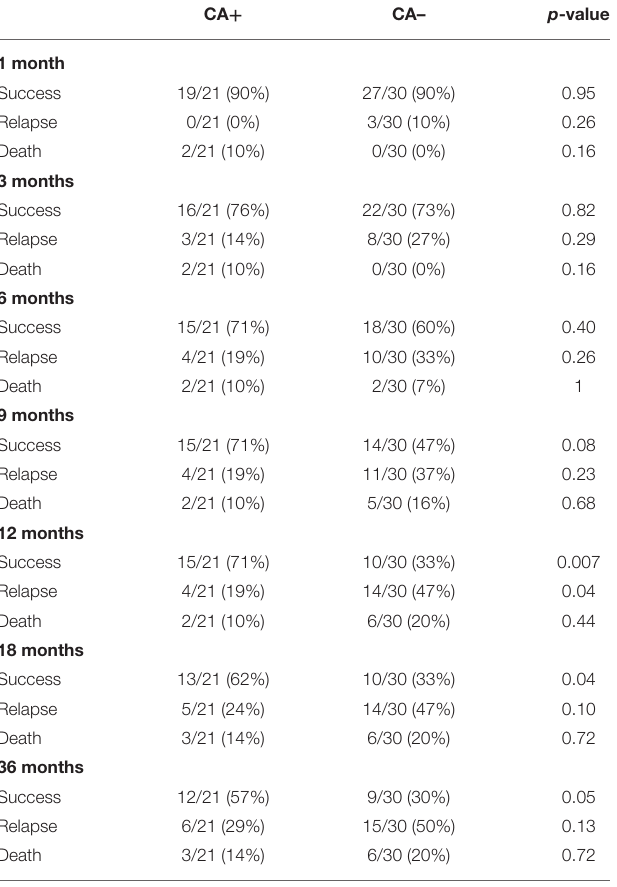
TABLE 3 | Success, relapse, and death rates for dogs in the cytosine arabinoside and non-cytosine arabinoside treatment groups. CA + CA– p -value